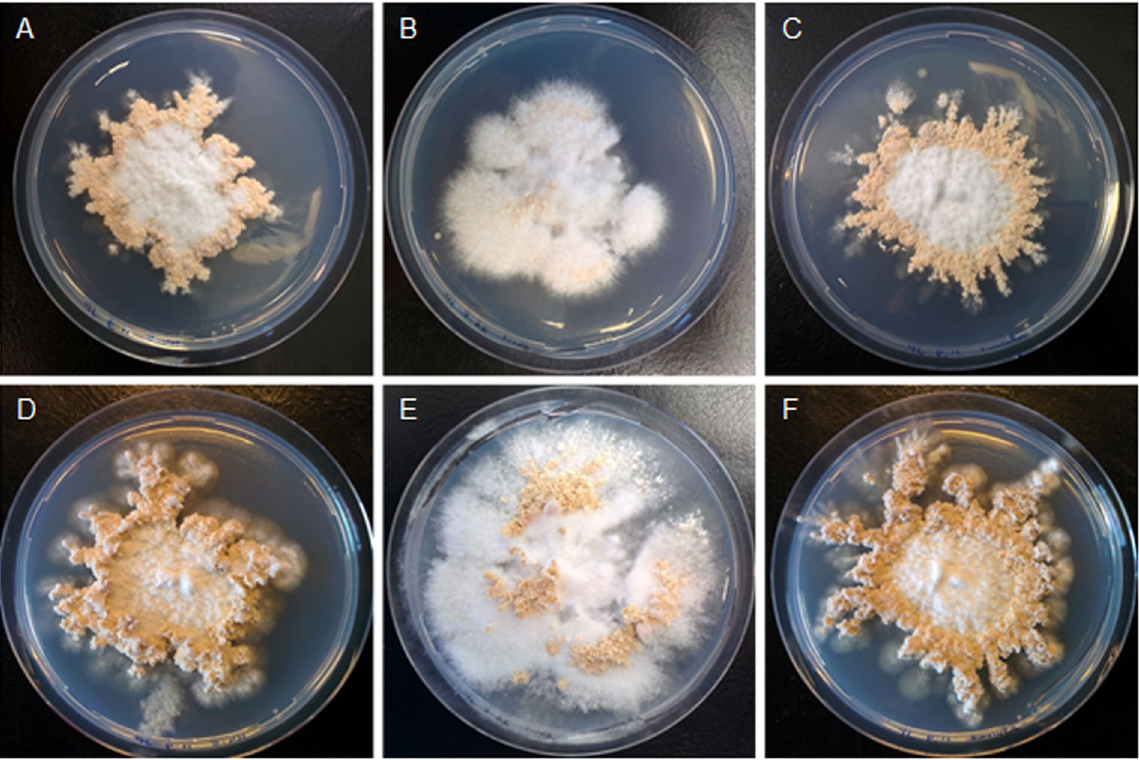
Figure 2. Fruiting body development of the wild-type dikaryon ( A , D ), Δ bri1 Δ bri1 ( B , E ), and Δ hom1 Δ hom1 ( C , F ) after 7 ( A–C ) and 15 ( D–F ) days of growth.